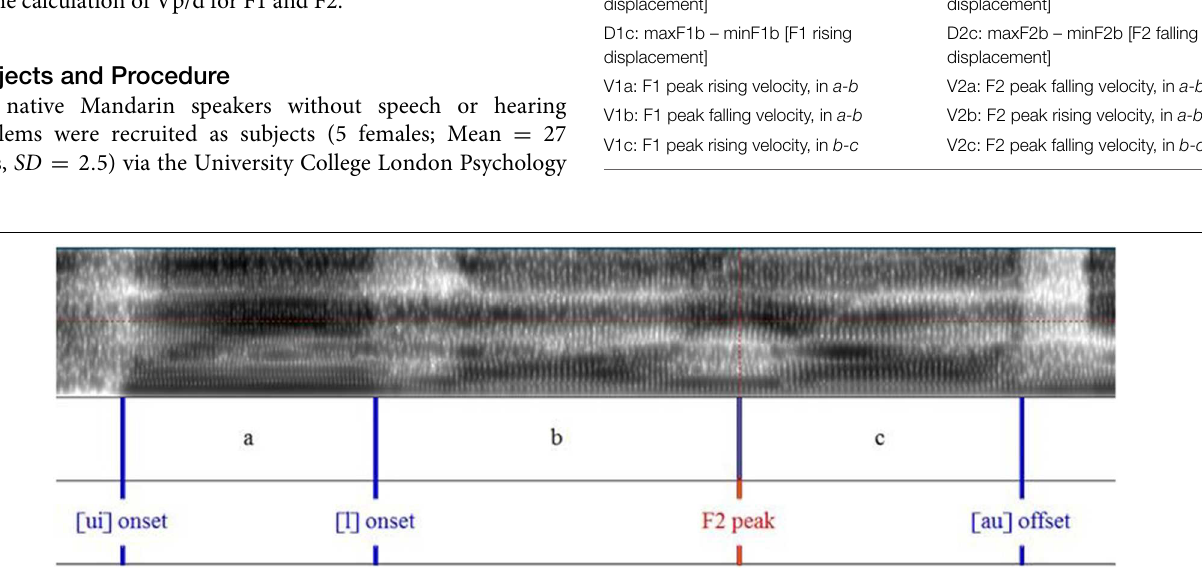
FIGURE 6 | Syllable segmentation and labeling of the sentence “Cui laoyao nian shu qu le .”